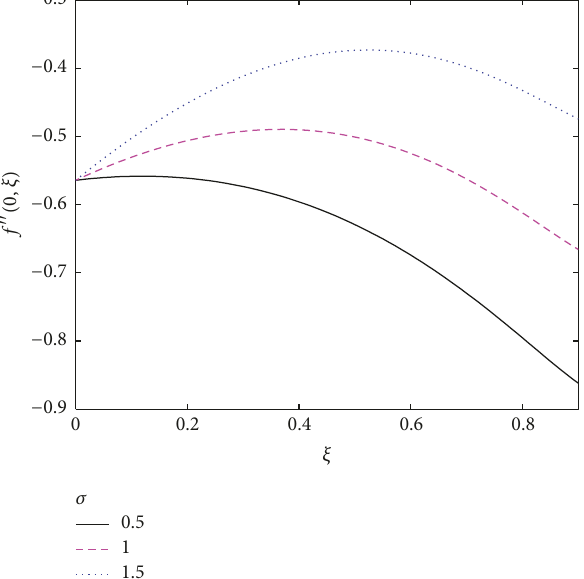
Figure 11: Effect of 𝜎 on 𝑓 󸀠󸀠 (0,𝜉) ( 𝜆 = 1, 𝛾 = 0.5, Pr = 3, Sc = 2, ℏ = −0.5